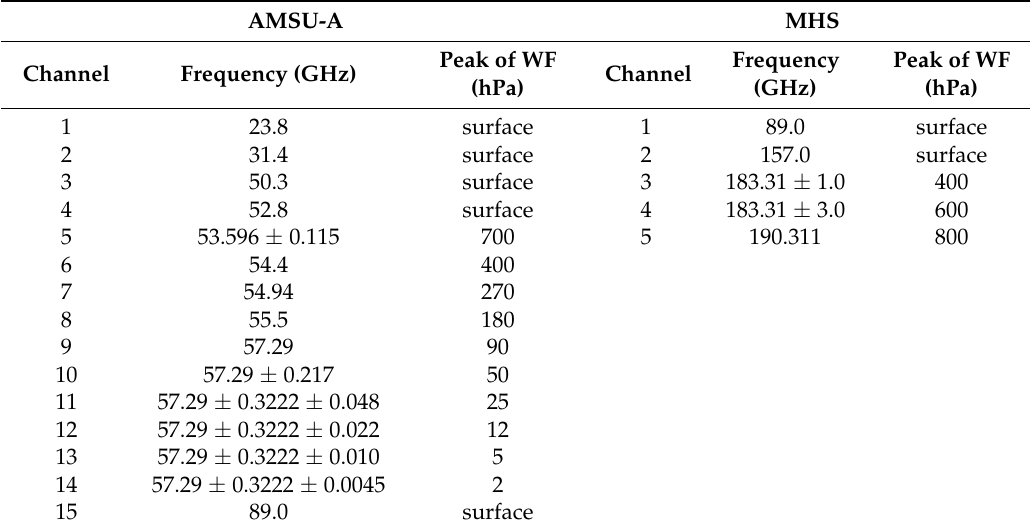
Table 2. Channel frequencies and peaks of weight functions (WFs) for AMSU-A and MHS. AMSU-A MHS Peak of WF Channel Frequency (GHz) (hPa)